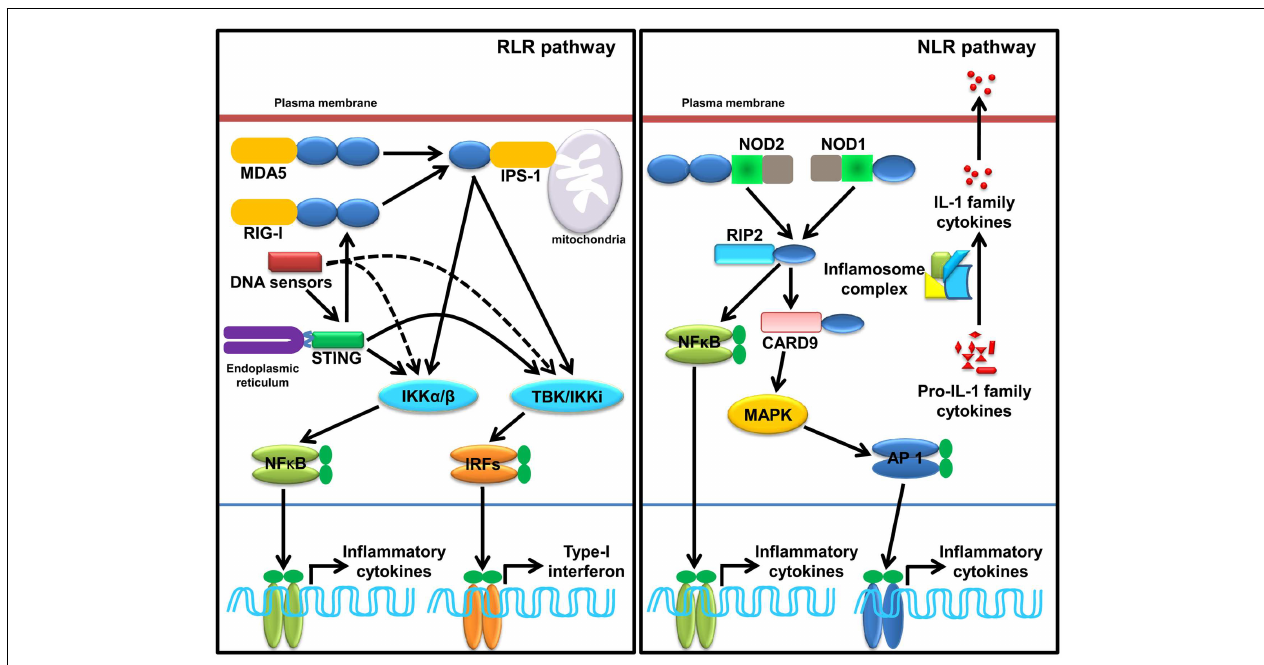
member, NOD1, NOD2, and inflammasome (mainly NLRP1 and NLRP3 and AIM2) induces inflammatory cytokine. NOD1 and NOD2 sense various SCPs (shown in Table 2 ) recruit an adaptor RIP2 and CARD9 for induction of inflammatory cytokines. Activation of inflammasome complex after stimulation with appropriate SCPs (shown in Table 2 ) process an inactive, proIL-1 family cytokine to active IL-1 family